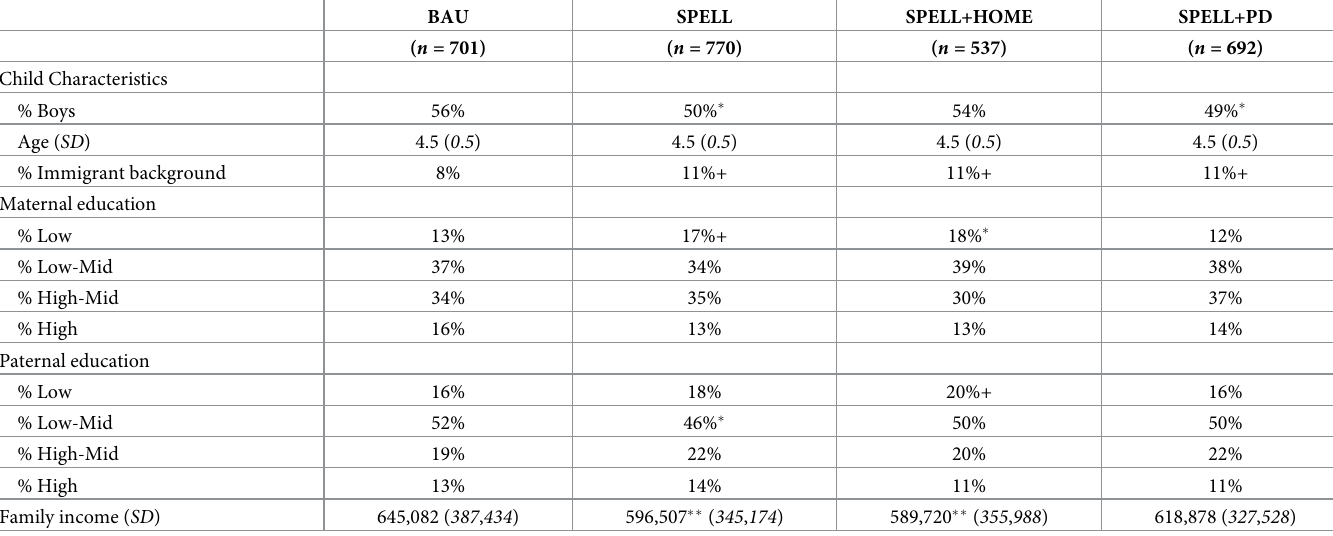
Table 2. Baseline characteristics of children in the long-term study of